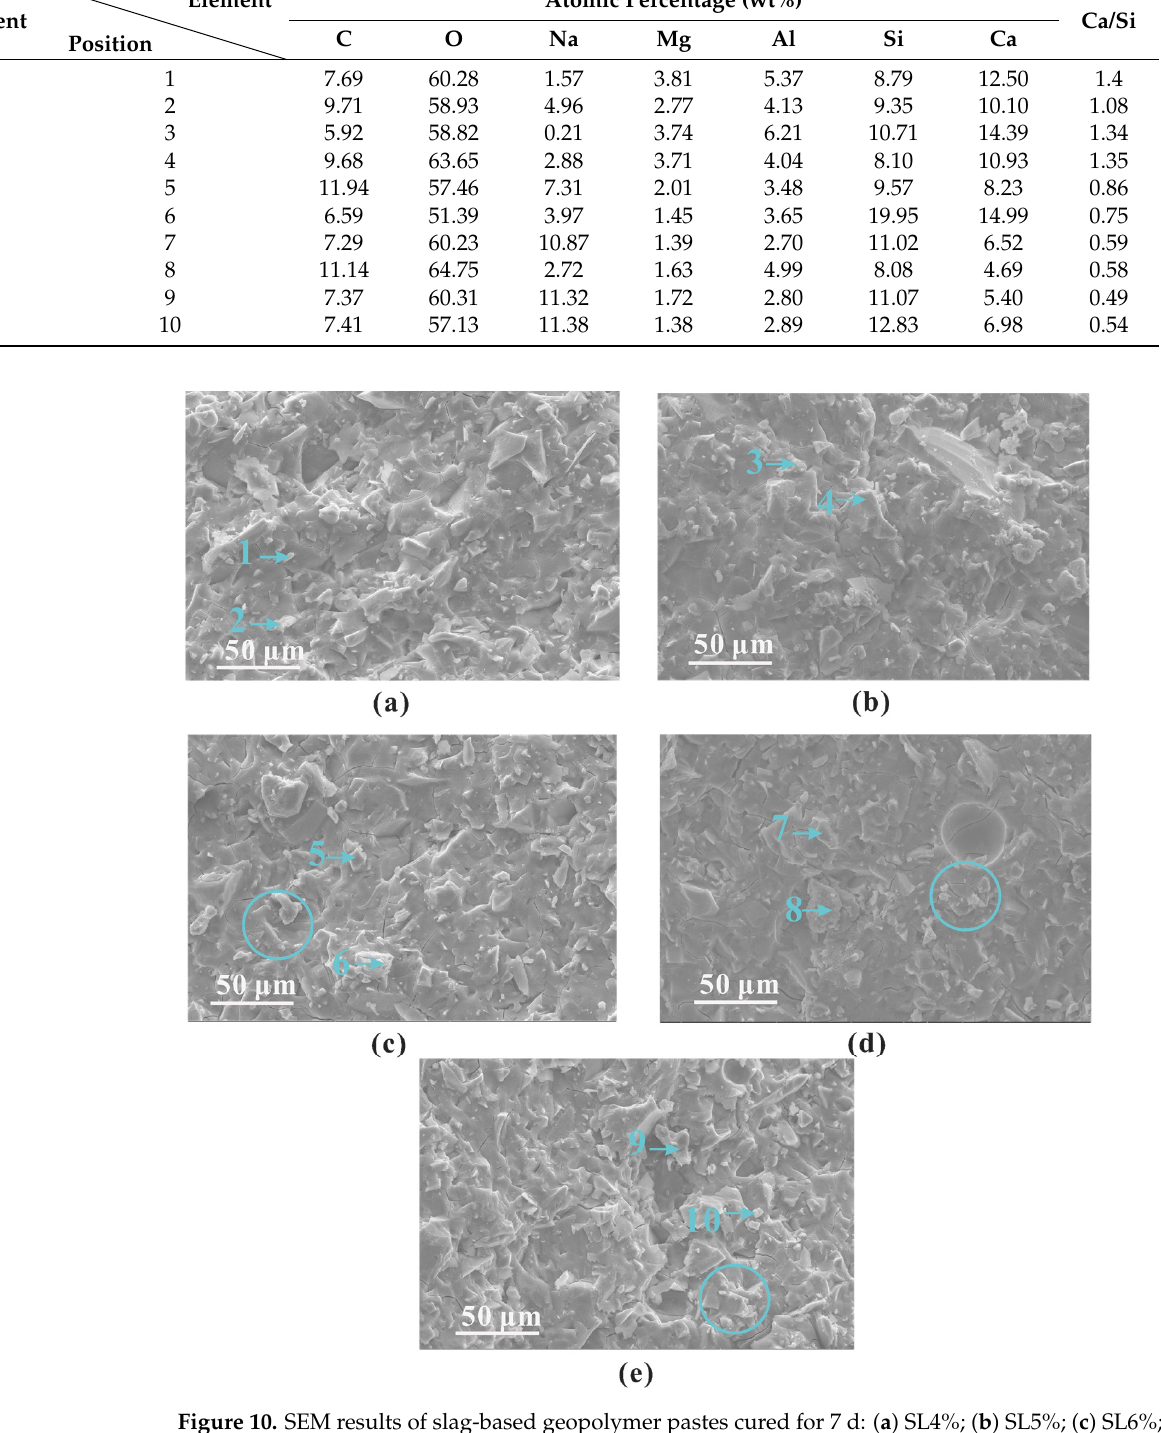
Figure 10. SEM results of slag-based geopolymer pastes cured for 7 d: ( a ) SL4%; ( b ) SL5%; ( c ) SL6%; ( d ) SL7%; and ( e ) SL8%. Note that the numbers in the images refer to the EDS numbers in Table 2.